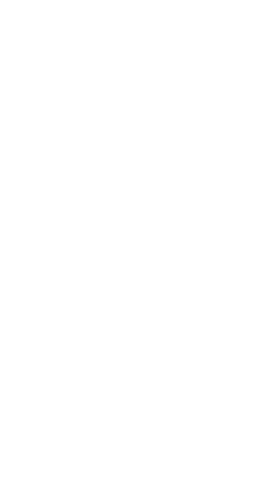
p -Value p -Value p -Value (Leaving (After Surgery (After Surgery Hospital vs. Leaving Control vs. Control vs. Hospital) Intervention)